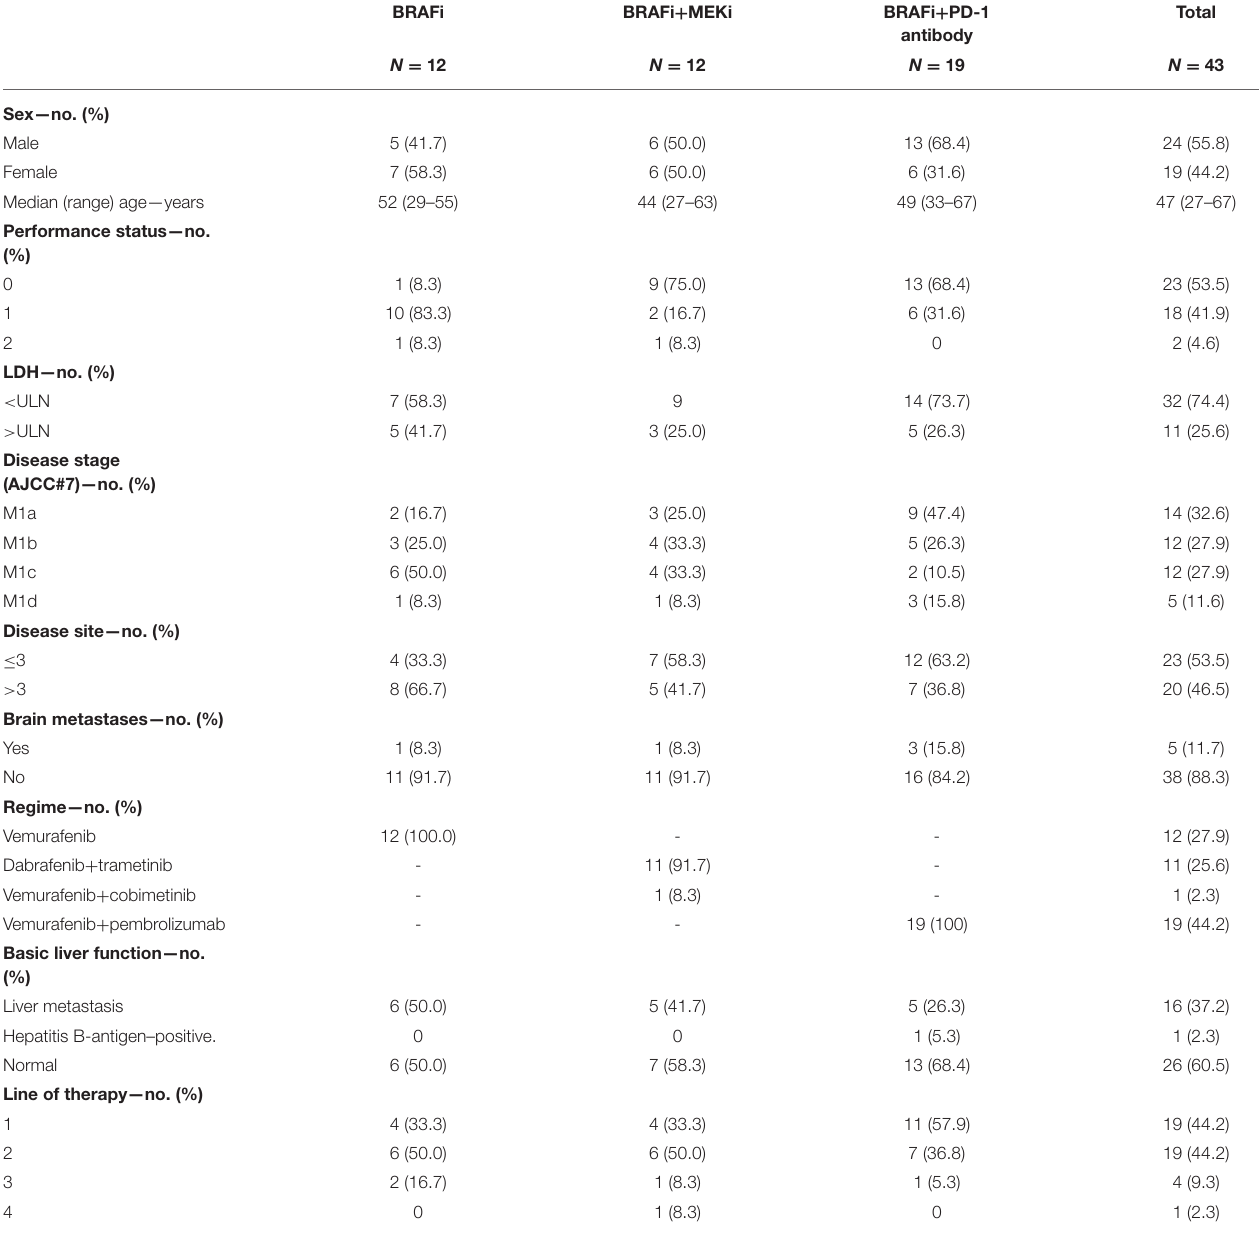
TABLE 1 | Clinical characteristics of the study population ( n = 43).